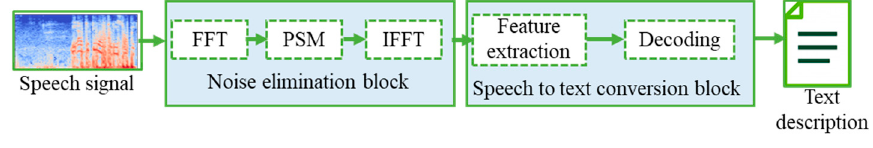
Figure 6. Proposed hybridized algorithm for speech enhancement. Algorithm 1 Hybrid Speech Enhancement Algorithm